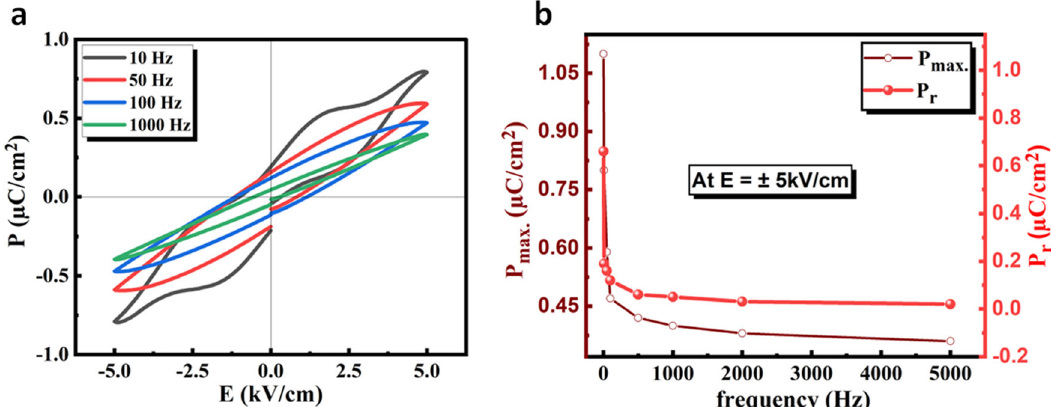
Fig. 3 Ferroelectric effect. a Ferroelectric hysteresis loops at different frequency ranges. b P r , P max versus frequency ranges at ±5 kV/cm of HT-Ti